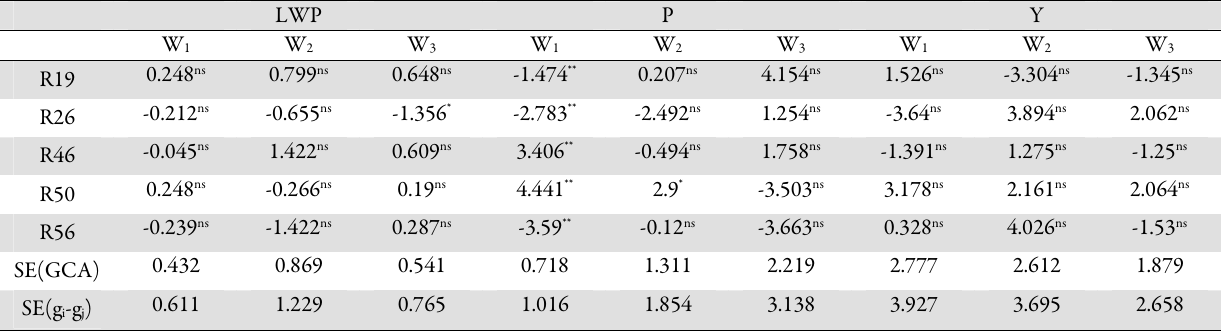
Tab. 4.2. Estimates of general combining ability of the male restorer lines for leaf water potential (LWP), proline content (P) and yield (Y) at the different levels of irrigation. Normal irrigation (W 1 ), mild water stress (W 2 ), severe water stress (W 3 )